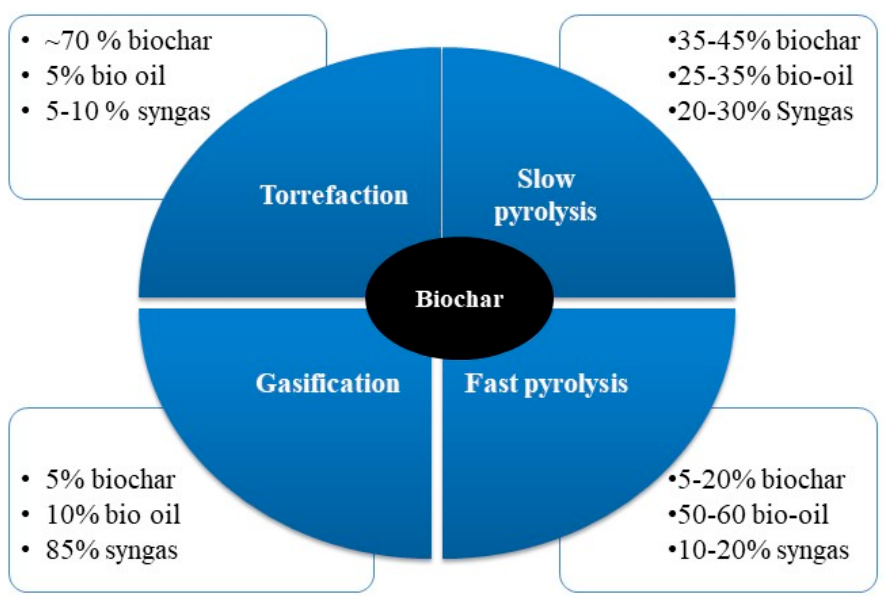
Figure 1. Effect of different pyrolysis methods on biochar yields.